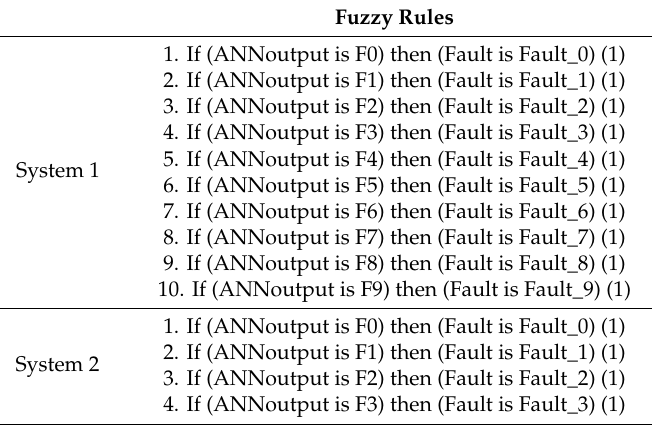
Table 9. Fuzzy classifier